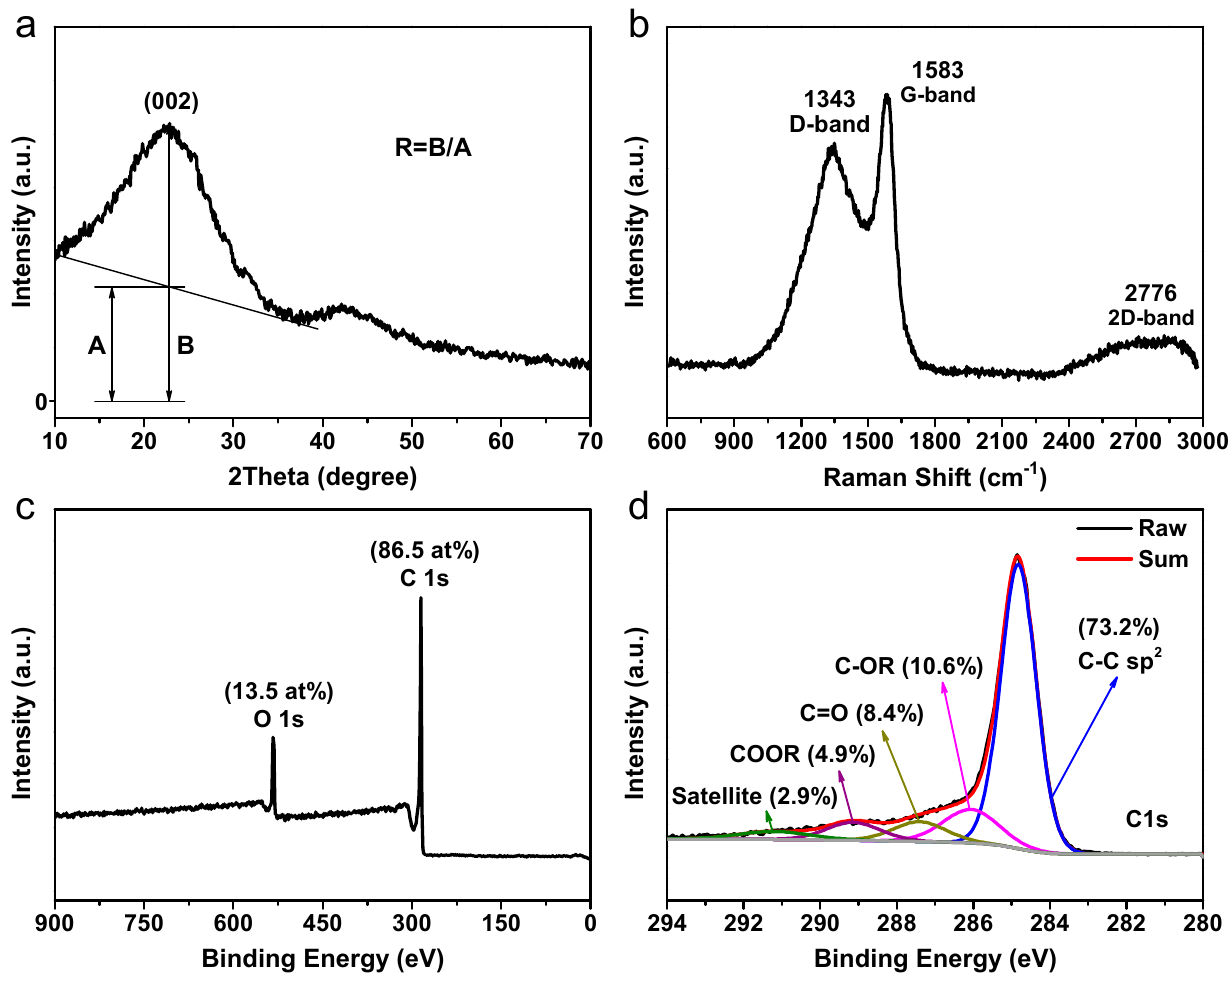
Figure 3. Structure and composition analysis of alginate ‐ derived Alg ‐ C carbon. ( a ) XRD pattern; ( b ) Raman spectrum, XPS full spectrum ( c ), and ( d ) high ‐ resolution of C 1s spectrum.